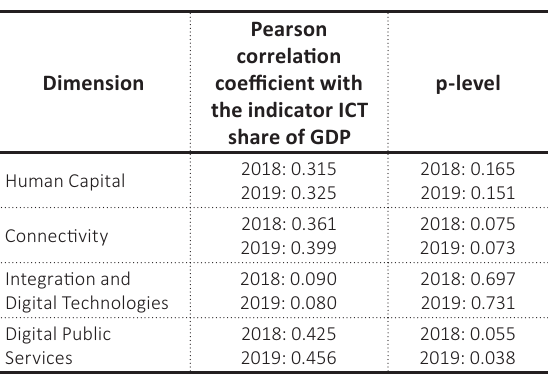
Table 2. Pearson correlation coefficient